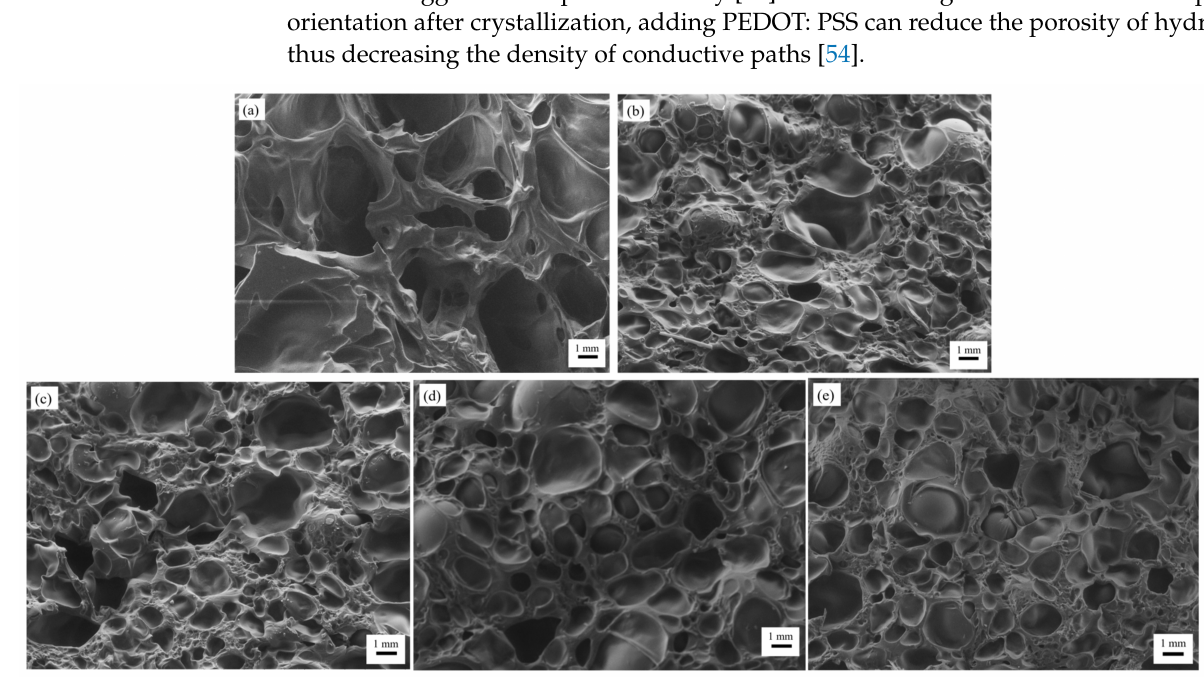
Figure 3. SEM micrographs of all samples: ( a ) Cs–Gel (control sample), ( b ) Cs–Gel–0.5% PEDOT: PSS, ( c ) Cs–Gel–1.0% PEDOT: PSS, ( d ) Cs–Gel–1.5% PEDOT: PSS and ( e ) Cs–Gel–2.0% PEDOT: PSS.